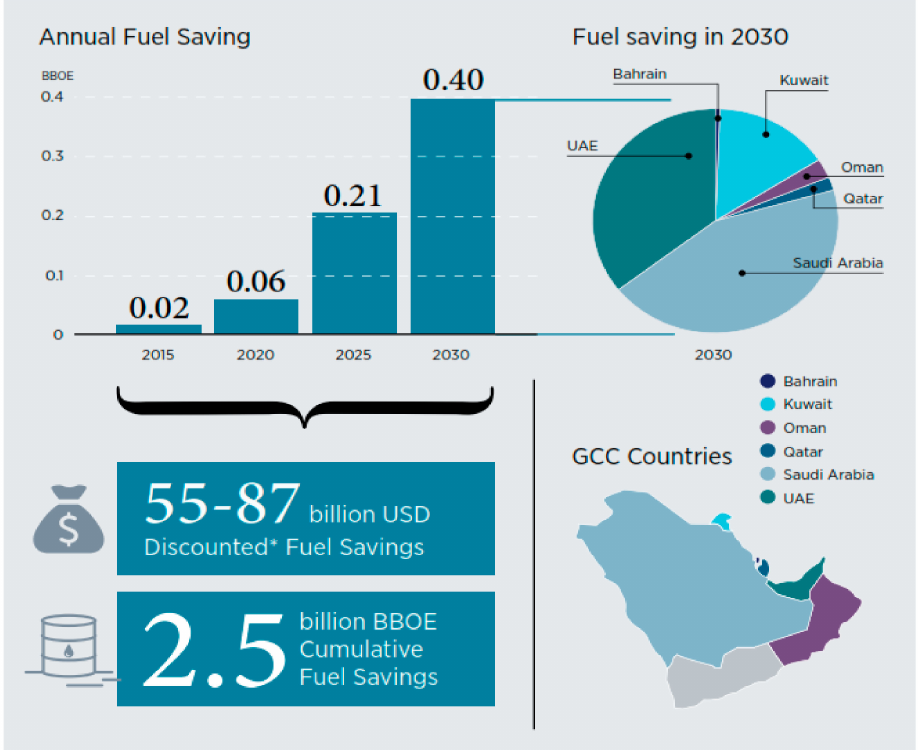
Figure 2. Fossil fuel savings from GCC RE targets by year and country